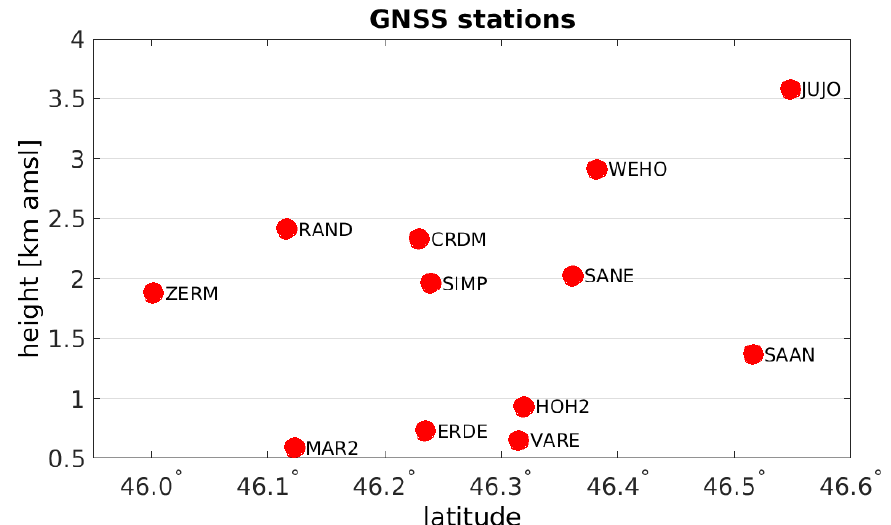
Figure 3. Height distribution of the 12 GNSS stations located close to the study area shown with respect to the latitude.